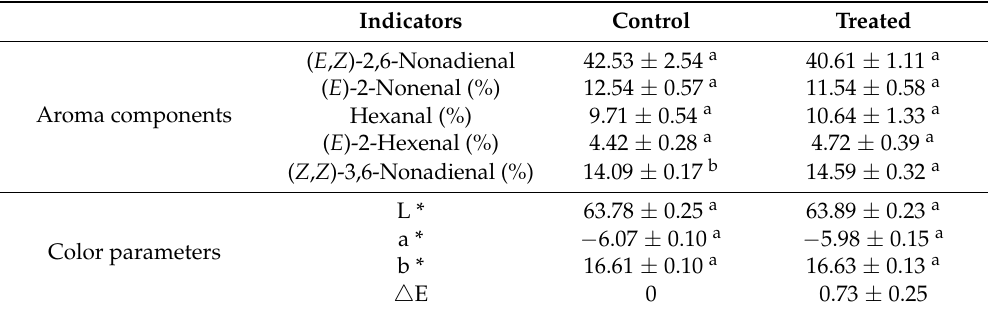
Table 2. Effect of APLTP treatment on sensory indicators of fresh-cut cucumber.